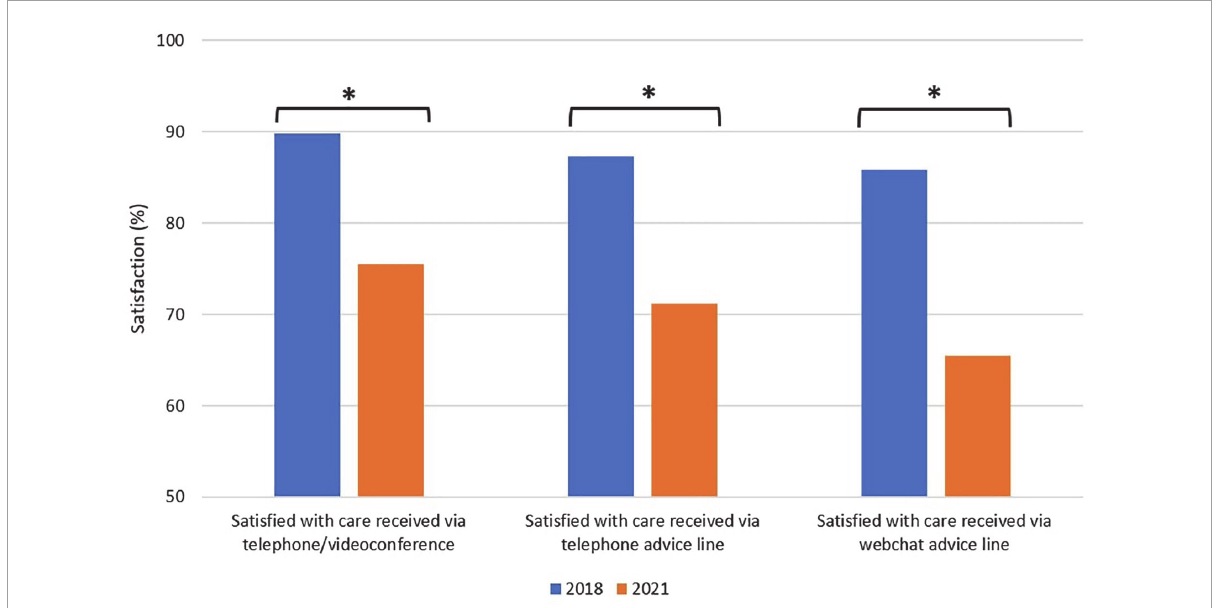
FIGURE1 Satisfaction with digital health services in 2018 and 2021. ∗ P < 0.05, ∗∗ P <